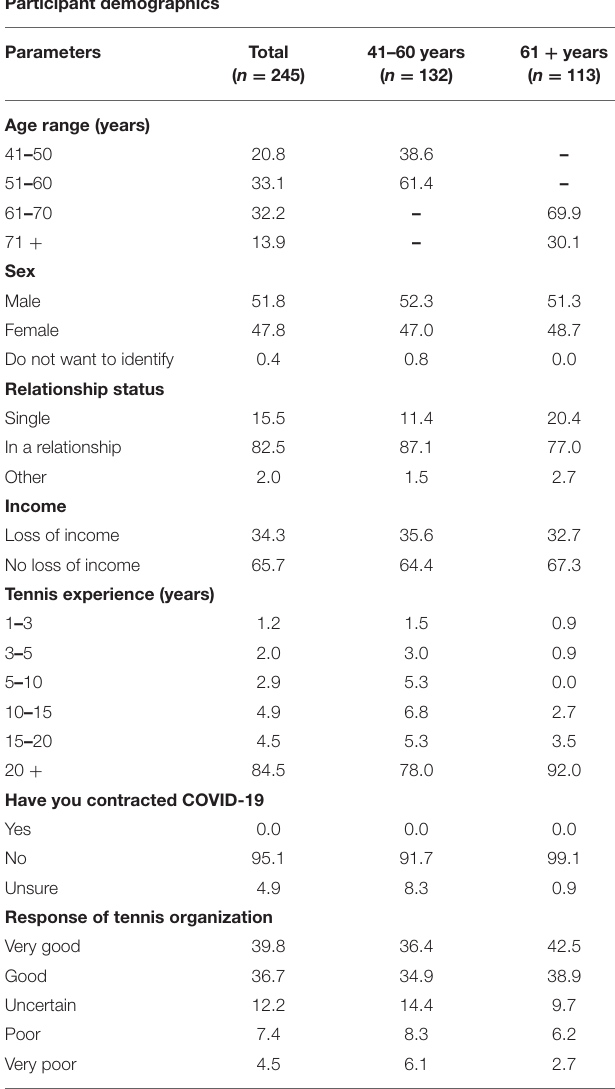
TABLE 1 | Participant information displayed as percentage of